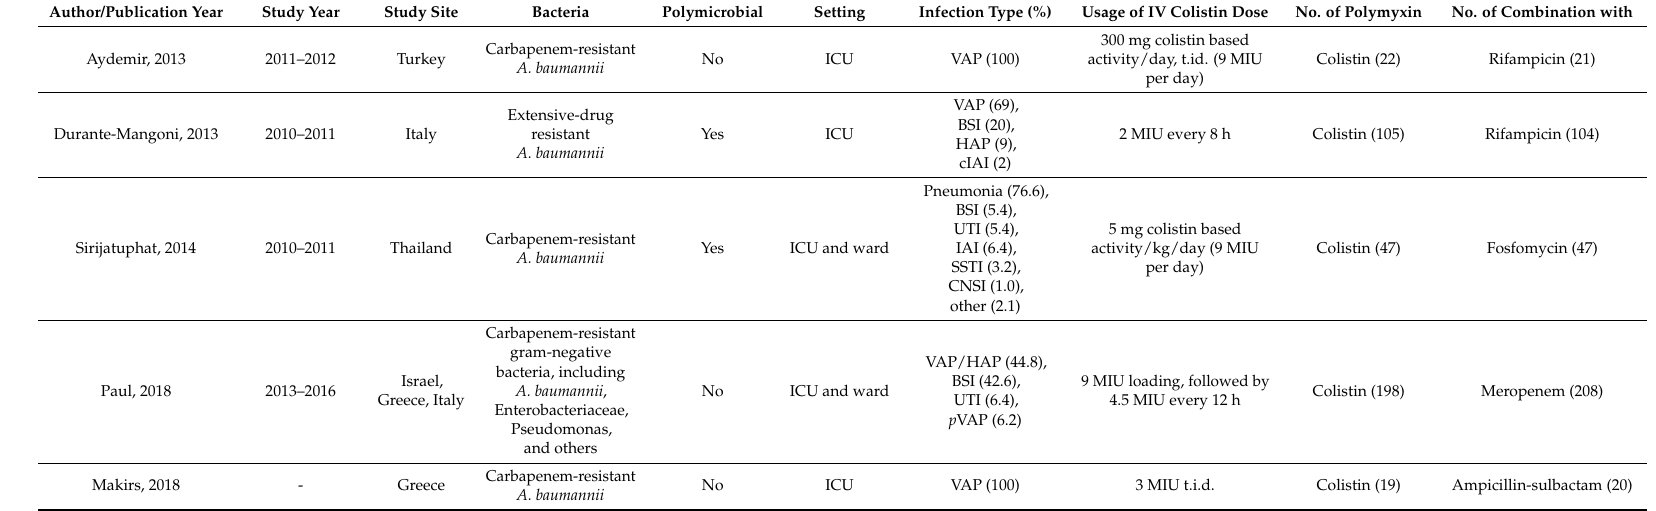
Table 1. Characteristics of included